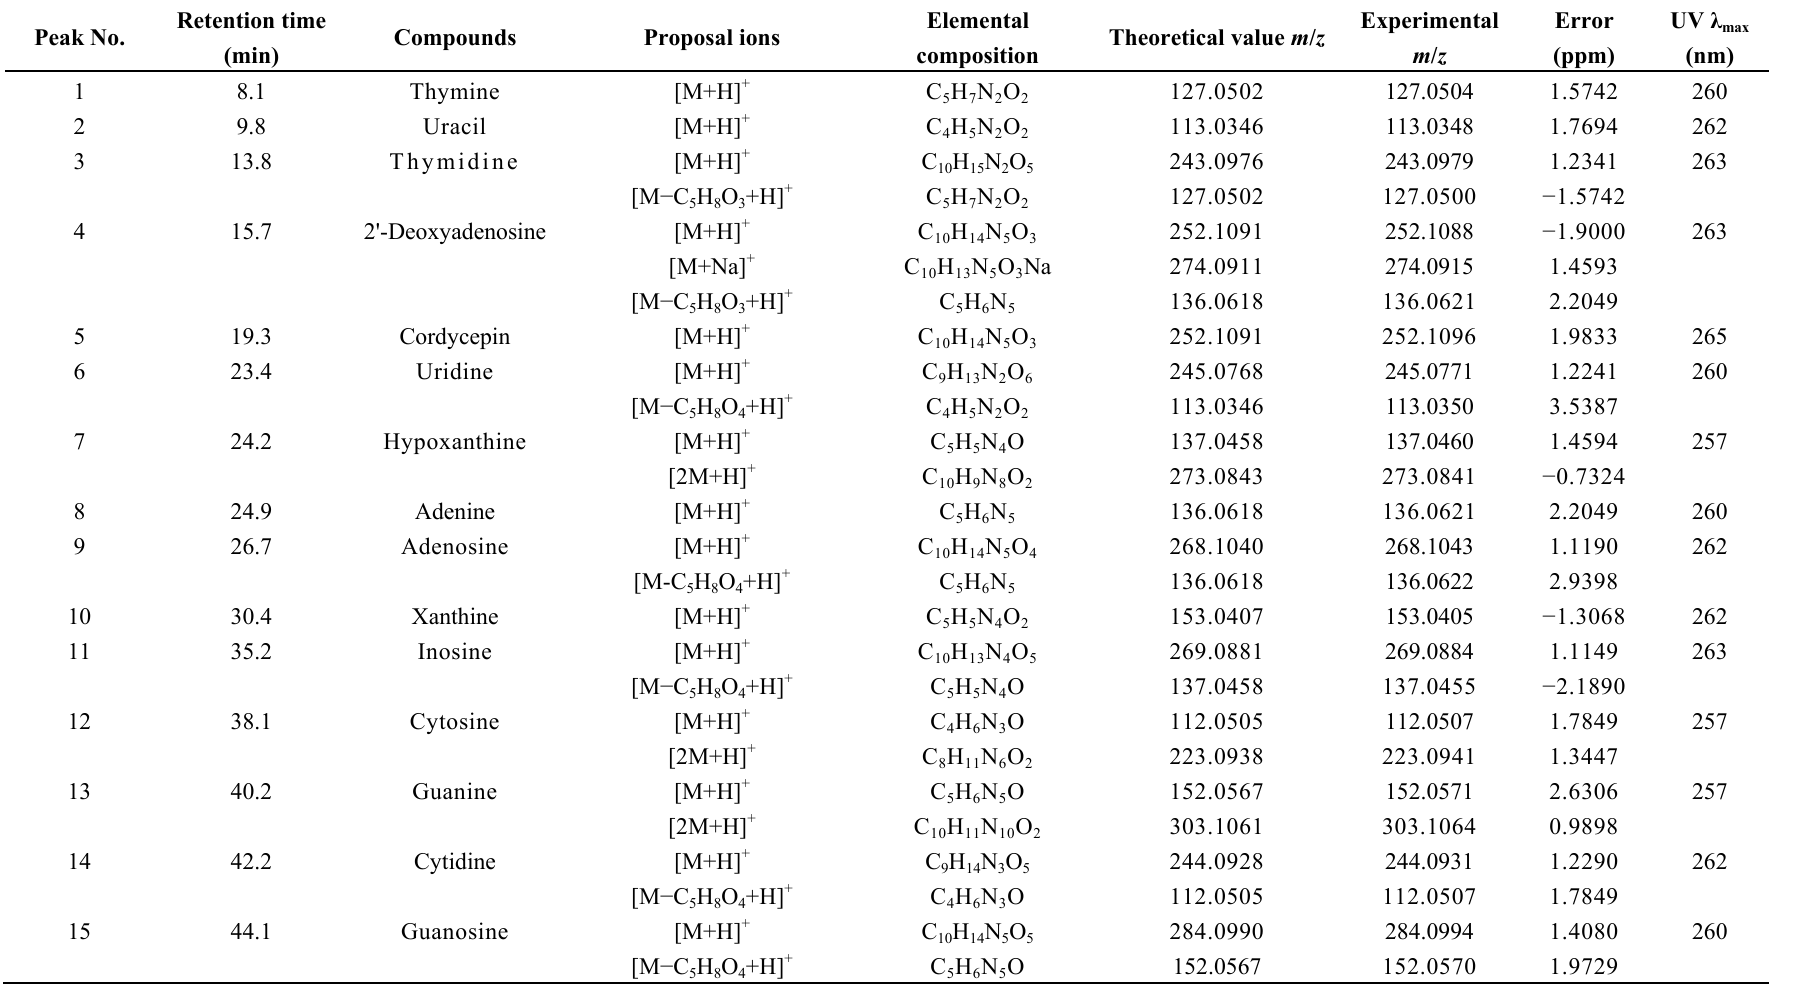
Table 2. HILIC-DAD-ESI-TOF/MS measurements for the extract of Cordyceps . Peak